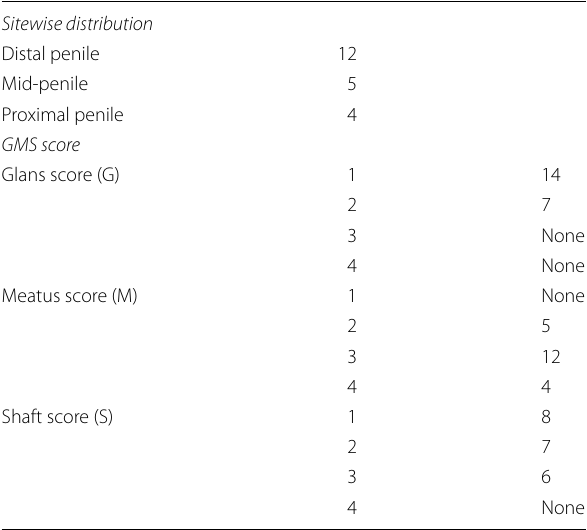
Table 2 Sitewise distribution and GMS score of the primary